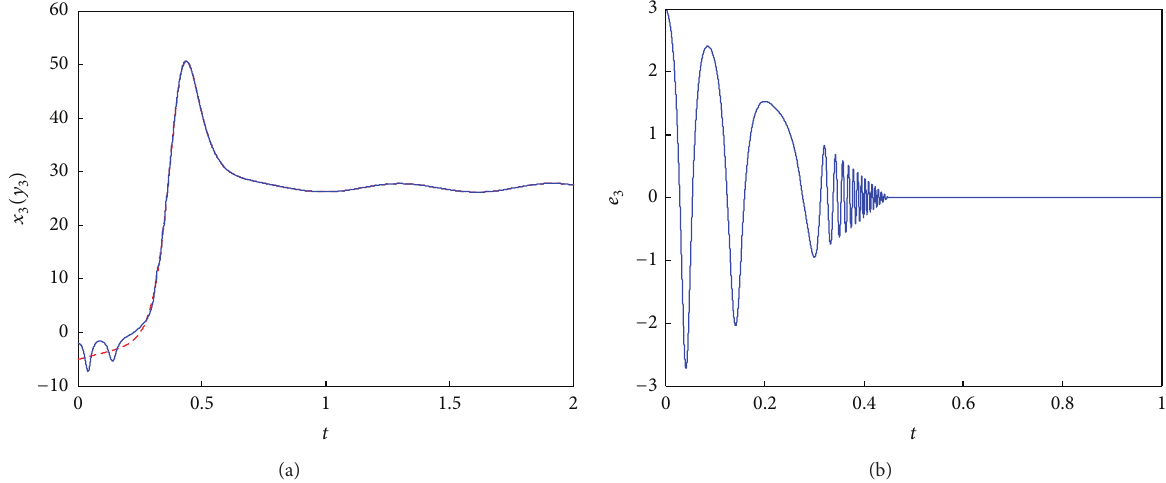
Figure 3: Time series and synchronization error of trajectories of the Lorenz system and the L ¨ u system: (a) 𝑥 3 (𝑦 3 ) versus 𝑡 ; (b) 𝑒 3 versus 𝑡